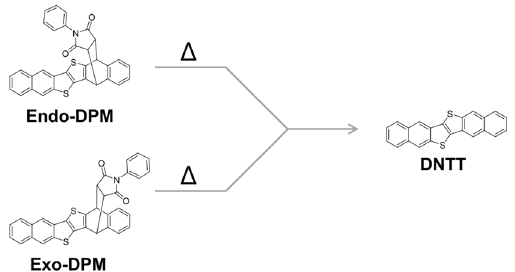
Figure 1. Structural conversion reaction of DPM to DNTT.